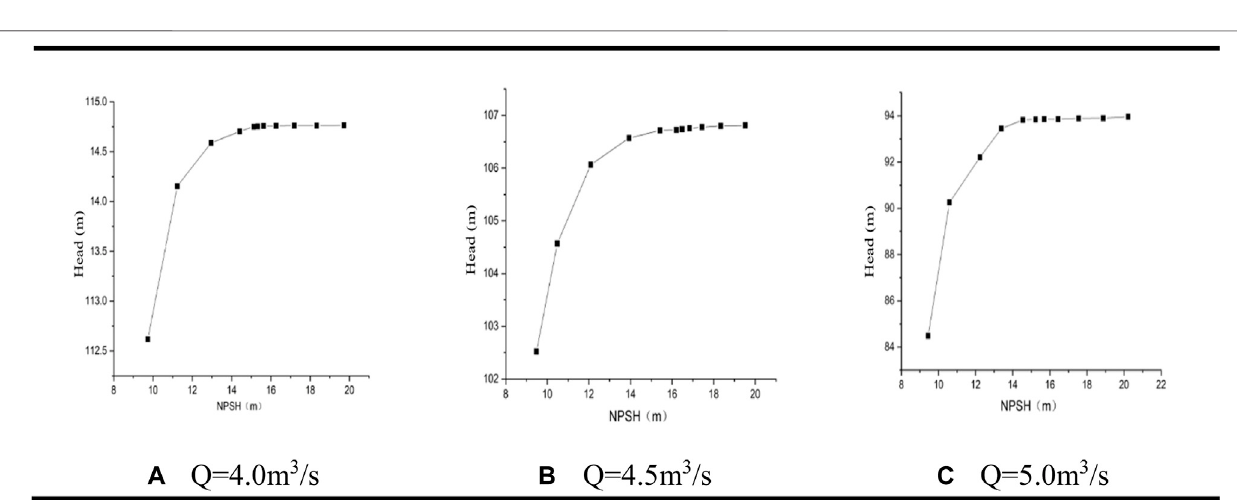
Frontiers in Energy Research |